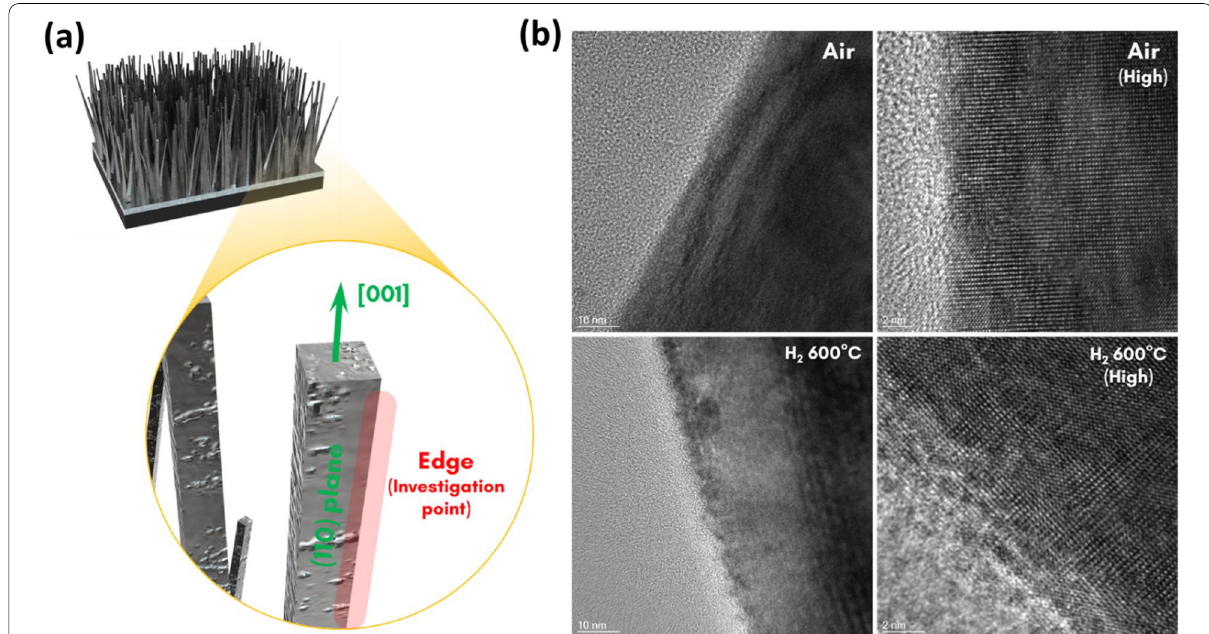
Fig. 2 a Schematics depicting the investigation point of the TiO 2 nanorods. The edge of the square-shaped nanorod, having the (110) plane as the side plane, was determined to clarify the exact crystallographic state of the surface. b TEM and HRTEM images of S, N-doped TiO 2 nanorods annealed under air at 350 °C and H 2 at 600 °C,